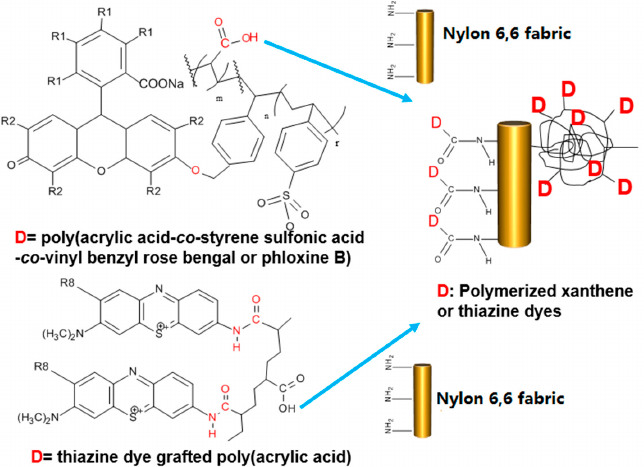
Figure 2. The grafting scheme of poly(acrylic acid ‐ co ‐ styrene sulfonic acid ‐ co ‐ vinyl benzyl rose bengal or phloxine B) or thiazine dyes grafted with poly(acrylic acid) (PAA) to the nylon fiber forming random coil shape. D is polymerized dye molecule such as polymerized xanthene dyes or thiazine dyes grafted with PAA. For RB, R 1 and R 2 are I and Cl. For PB, R 1 and R 2 are Br and Cl and TBO has methyl